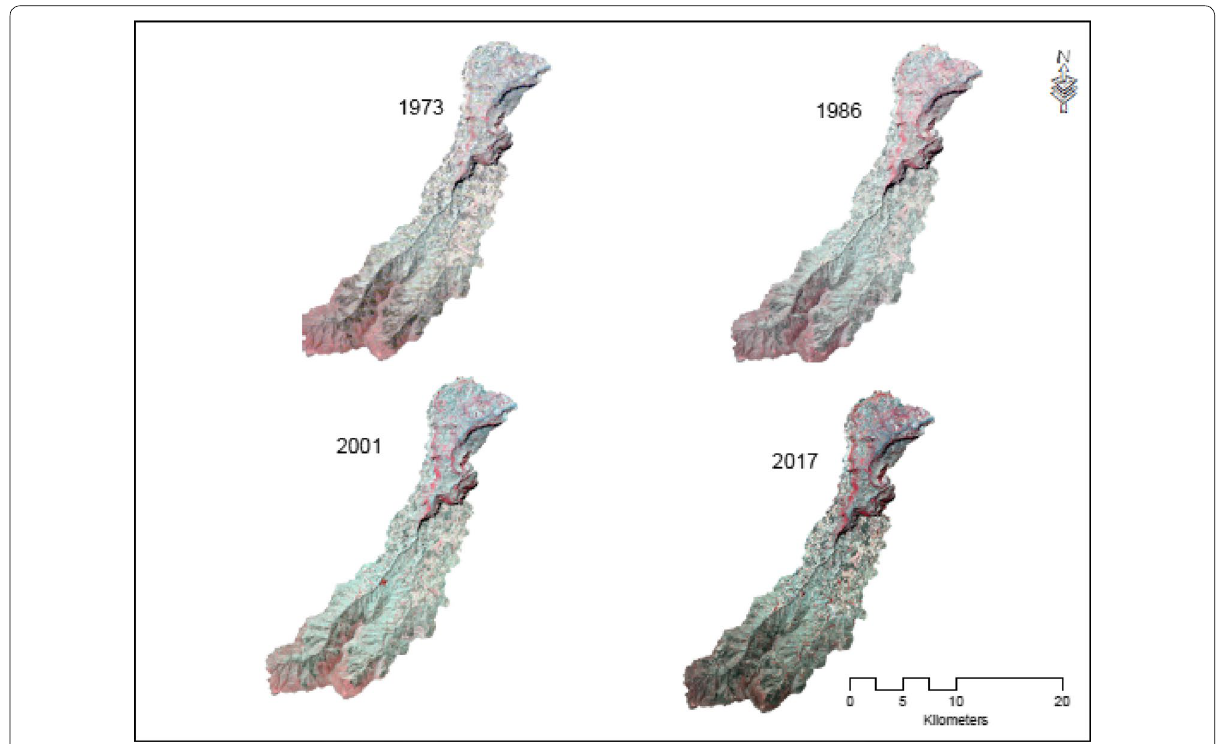
Fig. 5 Landsat images used for LULC classification and analysis